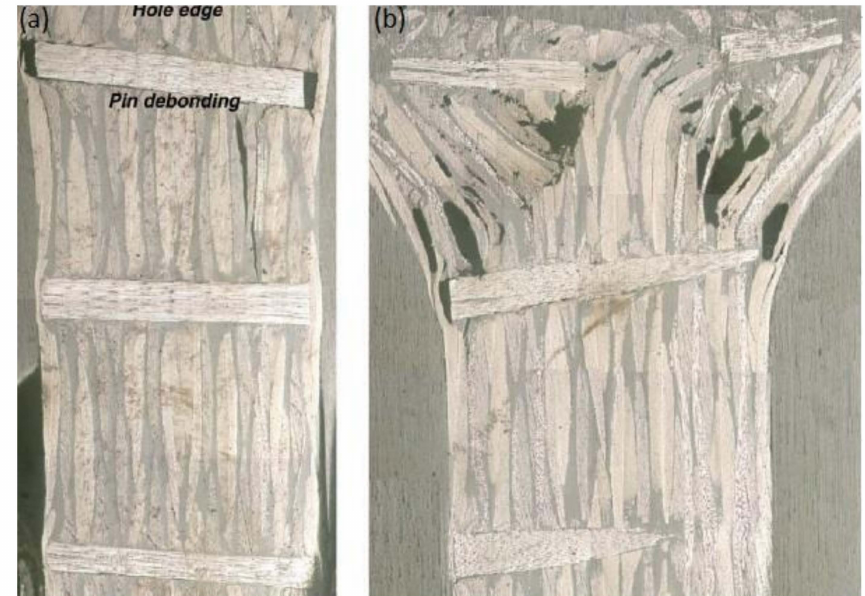
Figure 22. Section view of the laminate containing 2% carbon reinforced pins: ( a ) immediately after initial bearing failure and ( b ) after loading well beyond the maximum bearing load [156].